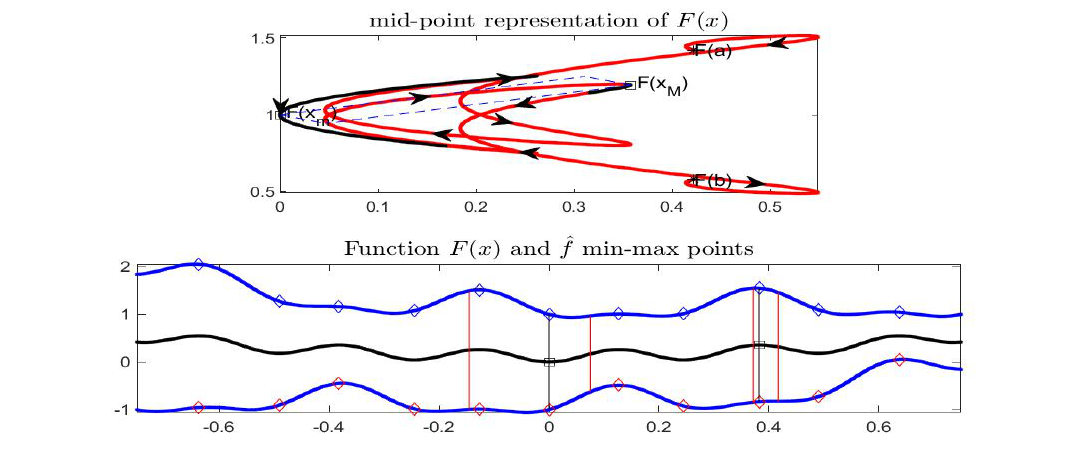
Figure 11. Complete Example: local convexity of curve C F corresponding to x m and x M (top picture). In the bottom picture, the values of x corresponding to local convex portion of F ( x ) are delimited by red vertical